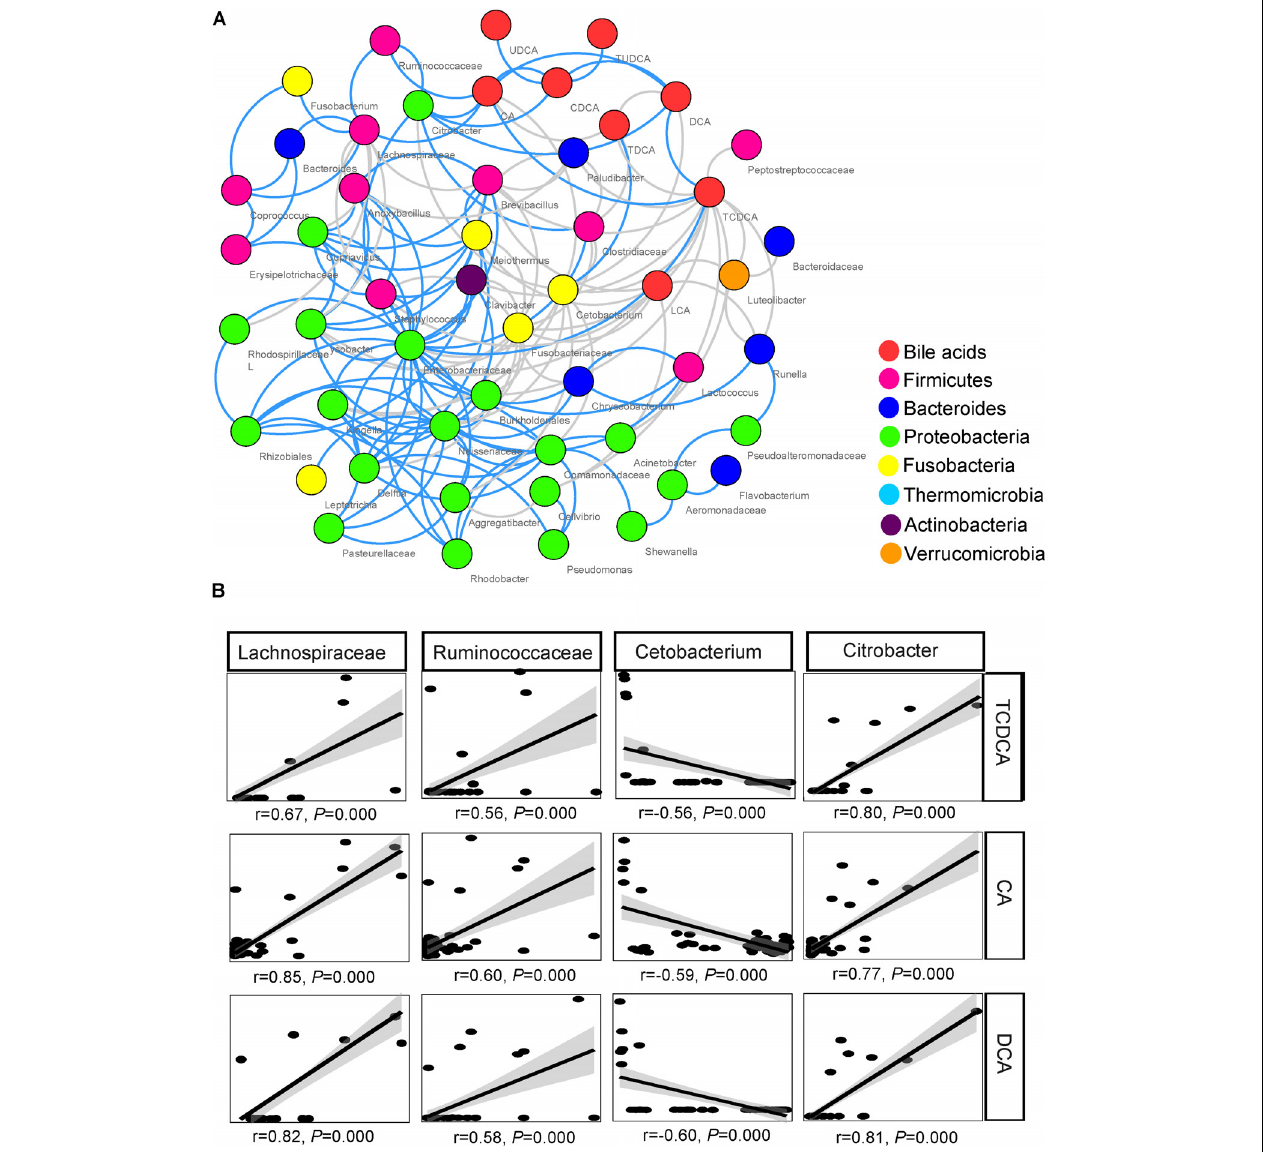
FIGURE 5 | Association between biliary BAs and taxa of gut microbiota. (A) Molecular ecological network (MEN) of biliary BAs and the top 50 microbial taxa at the genus level. A gray line indicates a negative correlation between two individual nodes, and a blue line a positive correlation. (B) Pearson correlations between three biliary acids and four key taxa of gut